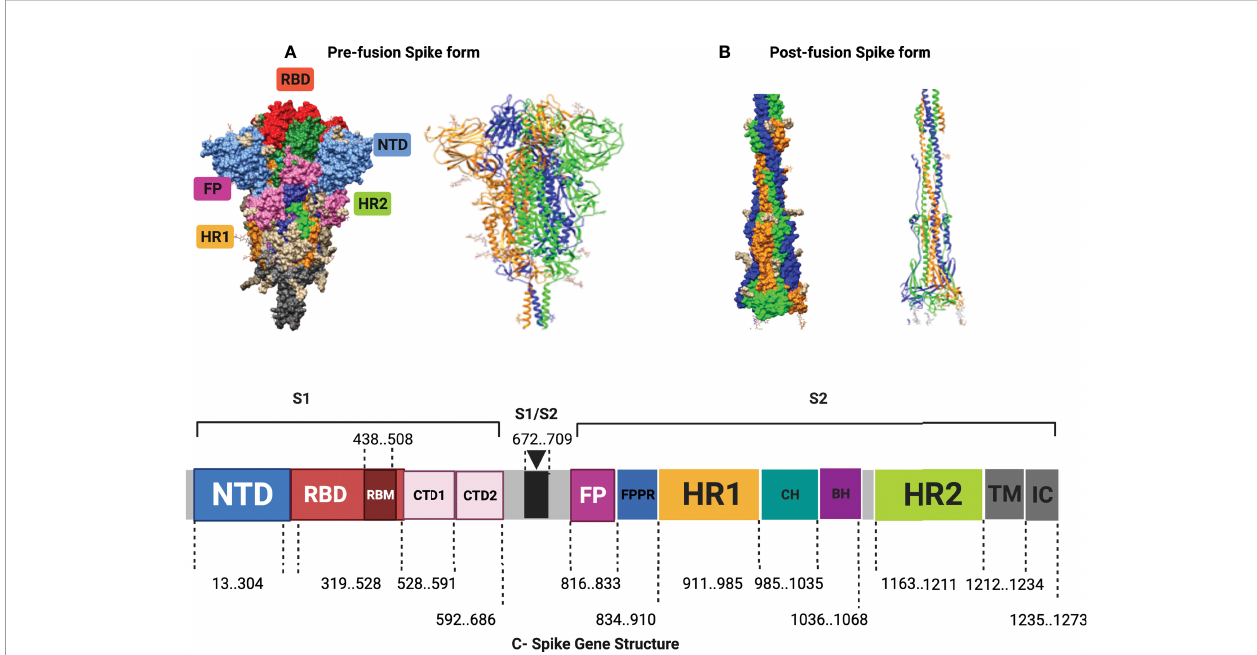
FIGURE 1 | The structure of the spike glycoprotein and its coding gene. (A) shows a schematic surface view of the spike ectodomain and its constituting domains and regions. (B) illustrates the structure of the native spike glycoprotein in its pre-fusion and post-fusion states as determined by Cryo-EM (PDB ID 6xr8 and 6xra, respectively) (Cai et al., 2020) in which the spike trimer is composed of three interacting chains or protomers depicted here in distinct colors. (C) demonstrates the detailed structure of the spike gene with the locations of the different regions shown according to the Wuhan strain (Reference Sequence NC_045512.2, Gene ID: 43740568) (Guruprasad, 2021; NCBI, 2021). The spike glycoprotein is composed of 2 subunits (S1 and S2). The S1 subunit includes the N-terminal domain (NTD), the receptor binding domain (RBD) which carries the receptor-binding motif (RBM), and two structurally conserved subdomains (the C- terminal domains 1 (CTD1) and the C- terminal domains 2 (CTD2). The S2 subunit contains the N-terminal hydrophobic fusion peptide (FP), the fusion peptide proximal region (FPPR), the heptad repeat 1 (HR1) motif, the central helix region (CH), the b -hairpin region, the connector domain (CD)and the heptad repeat 2 (HR2) motif. These are followed by the transmembrane region (TM) and the intracellular regions (IC) (Guruprasad, 2021; NCBI, 2021). The fi gure was assembled with Biorender website (Biorender,